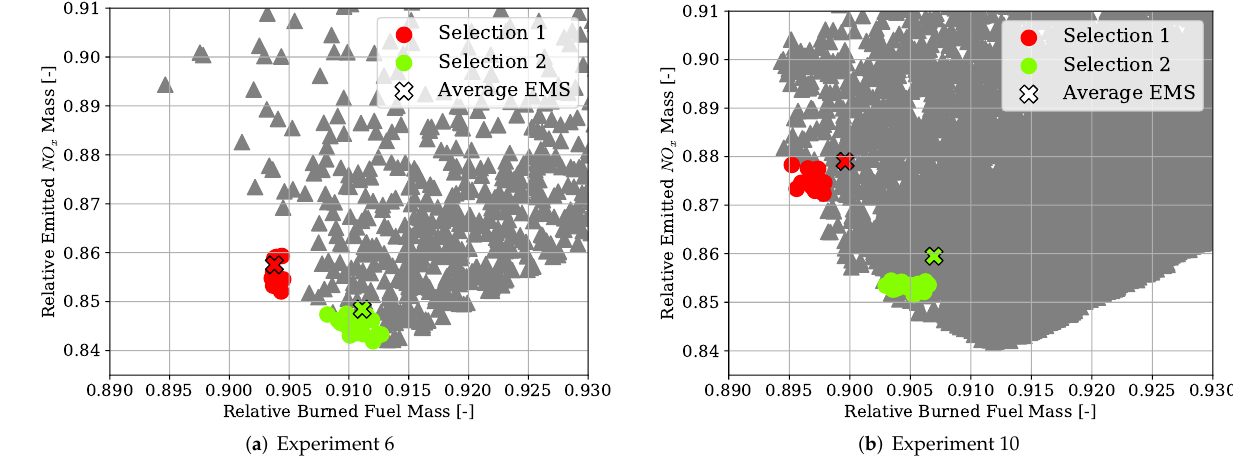
Figure 15. Points selected for the recommended